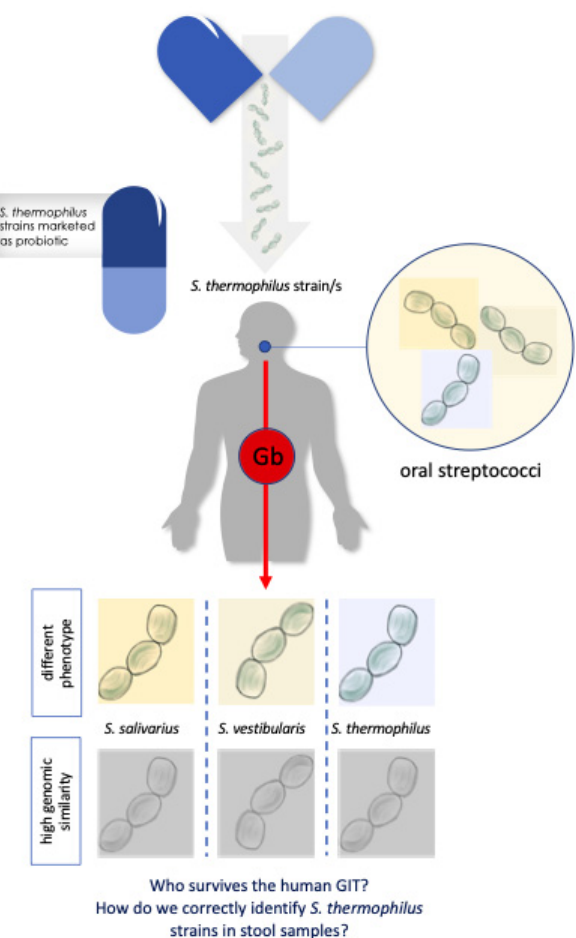
Figure 1. Schematic representation of the criticisms associated to the identification of S. thermophilus strains in human stool samples during intervention studies. Gb, gastric barrier; GIT, gastrointestinal tract.